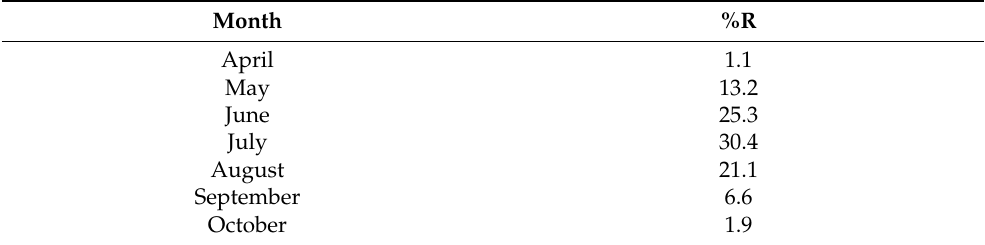
Table 2. Monthly distribution of the R-factor for the Czech Republic [37].